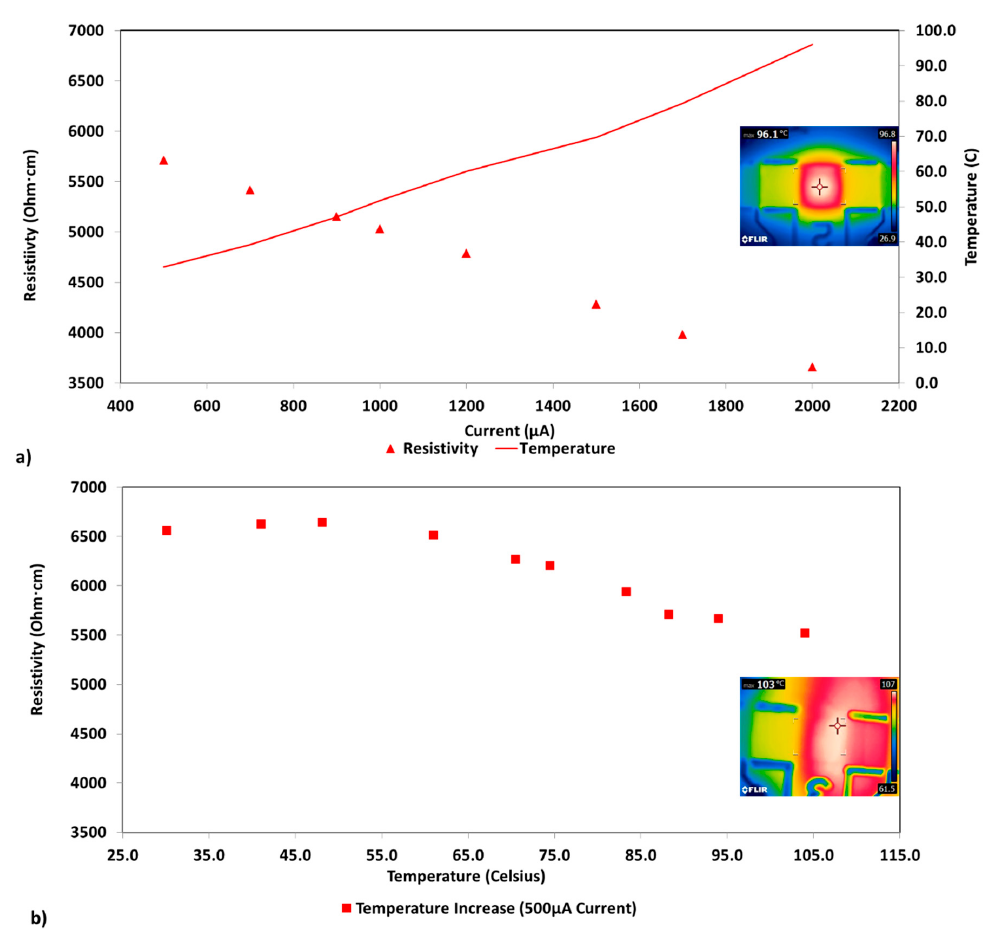
Figure 3. Temperature impacts on resistivity. ( a ) Increasing current from 500 µ A to 2000 µ A with a 0.014 wt% CNT sample. ( b ) Increasing temperature from room temperature to greater than 100 degrees Celsius with a 0.014 wt% CNT sample at a constant current of 500 μ A .